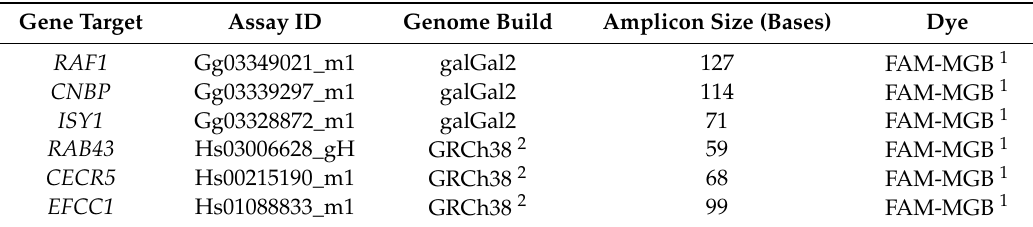
Table 1. TaqMan assays were used to investigate transcript presence and quantity from genes identified within the wg-2 227-kb GGA 12 linked